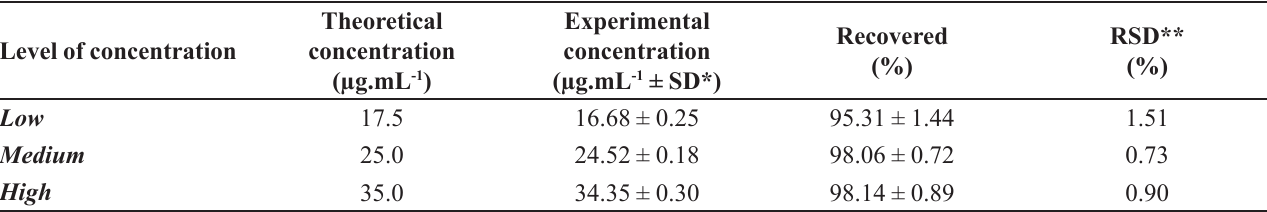
Level of concentration